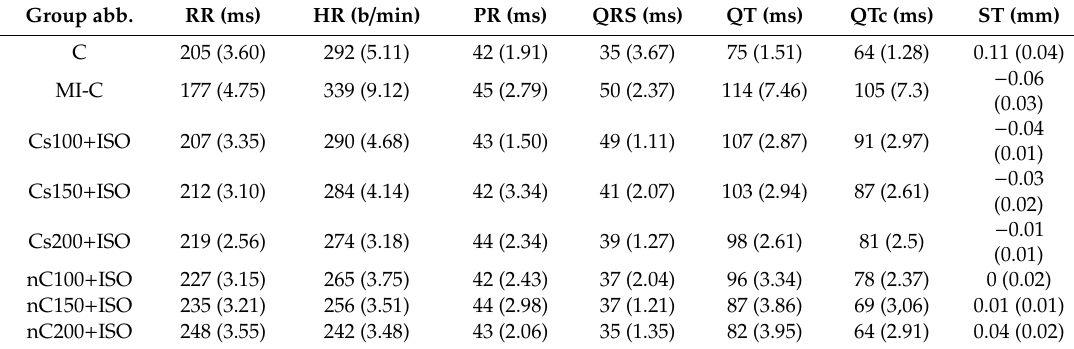
Table 4. ECG characteristics by group after ISO administration.